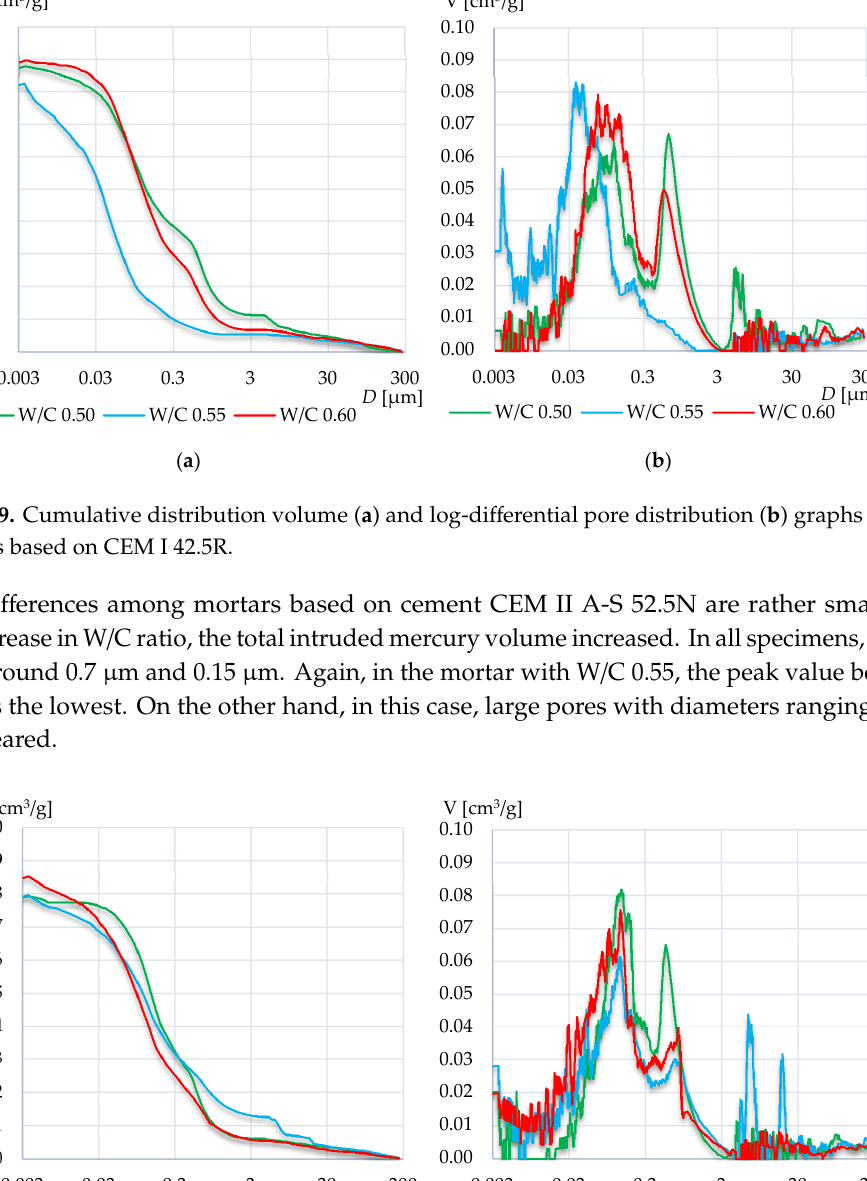
Figure 8. Cumulative distribution volume ( a ) and log ‐ differential pore distribution ( b ) graphs of the mortars based on CEM III A 42.5N.